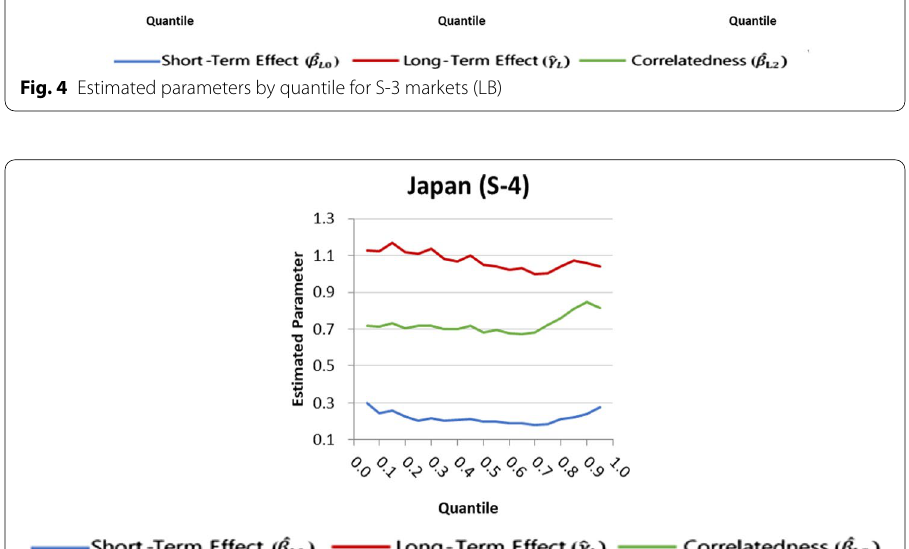
Fig. 5 Estimated parameters by quantile for S-4 markets (SB)